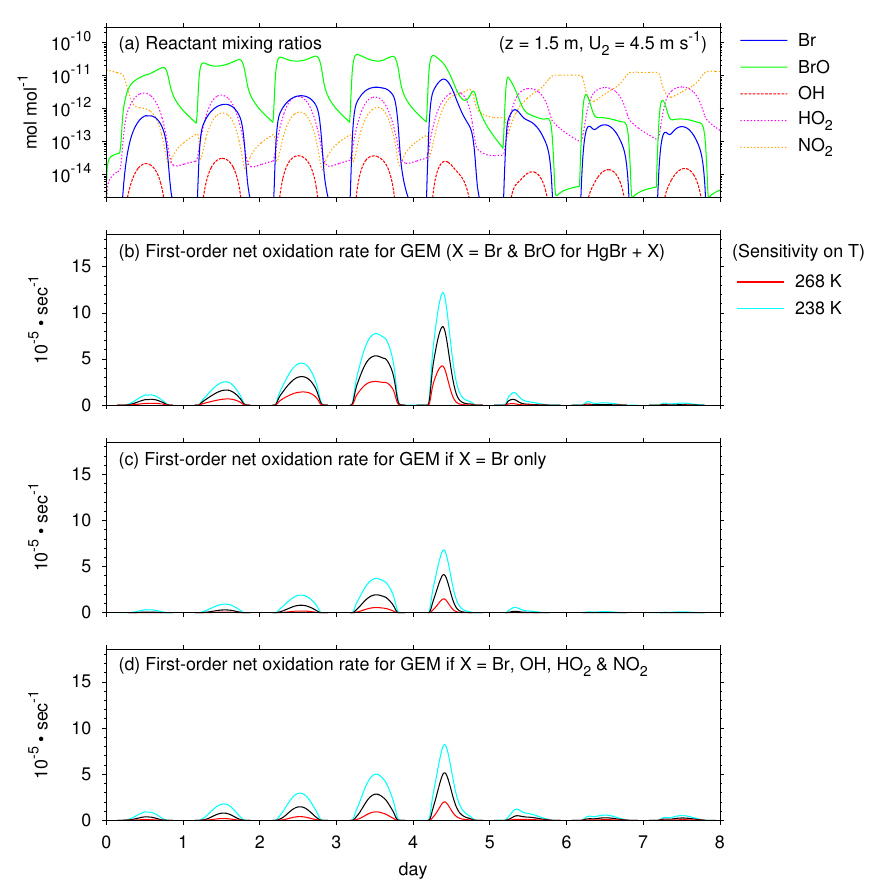
Fig. 8. (a) Temporal evolution for the mixing ratios of potential reactants (Br, BrO, OH, HO 2 and NO 2 ) for Hg and HgBr in the gas phase at the height of 1.5m in the ambient air from a model run employing scenario 1A at U 2 = 4 . 5ms − 1 ; (b) First-order net oxidation rates of GEM calculated at 1.5m height from this model run (black line). Potential changes in the net GEM oxidation rates arising from changes in temperature are also estimated by raising (red line) and dropping (light-blue line) temperature by 15K from 253K for the calculation of rate constants of gas-phase Hg oxidation kinetics while using the output of the model run at 253K; (c) the same as (b) but re-estimated by assuming only Br-atoms can react with HgBr to form a stable Hg(II) product (i.e., the reaction HgBr+BrO switched off); and (d) the same as (c) but re-estimated by assuming OH, HO 2 and NO 2 can react, in addition to Br, with HgBr to form stable Hg(II)